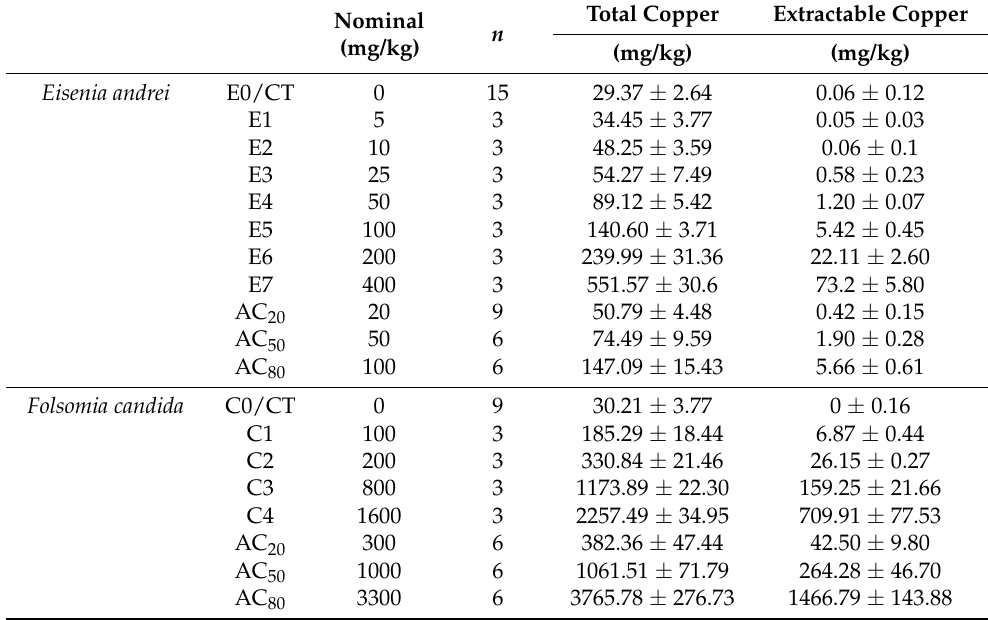
Table 2. Nominal concentrations (expected) and total and extractable concentrations (measured; average ± standard deviation) of copper in soil treatments used in the avoidance tests, individual placement tests, small-scale gradient tests and large-scale gradient tests, using Eisenia andrei or Folsomia candida as test organisms. E0-E7 and C0-C4 refer to treatments used in avoidance tests with E. andrei and F. candida , AC 20 -AC 80 , avoidance concentrations (estimated at the initial avoidance tests), used in the other tests for each species, respectively. Total Copper Extractable Copper Nominal n (mg/kg)